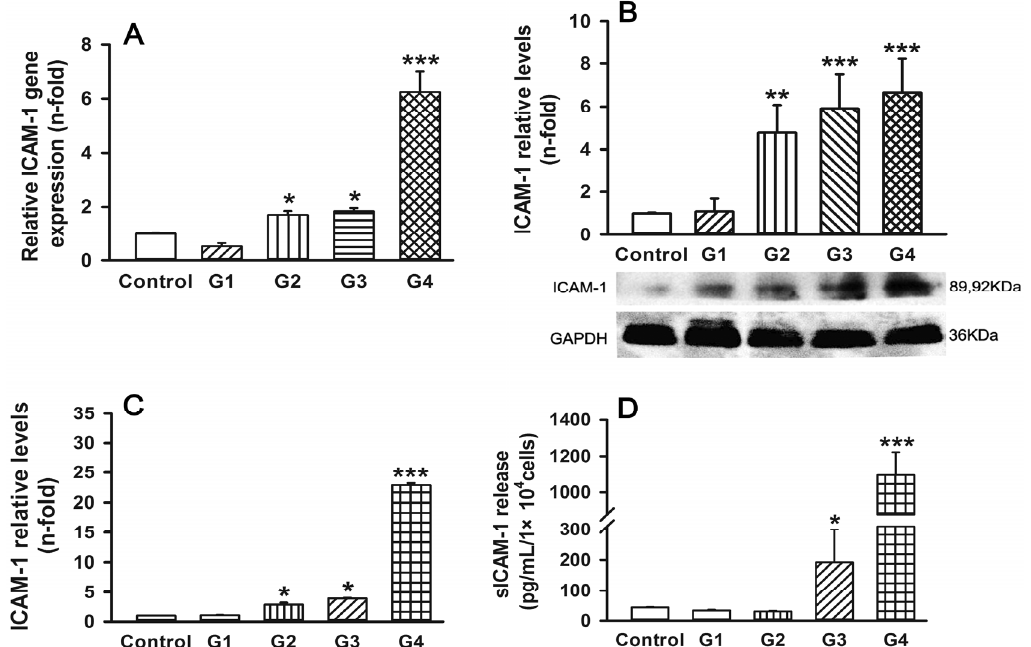
Figure 5. RSV-induced ICAM-1 expression and secretion in 16HBE cells. ( A ) Total RNA was analyzed for ICAM-1 mRNA levels; ( B ) Whole-cell lysates were analyzed for ICAM-1 protein levels using western blotting; ( C ) ICAM-1 protein levels were expressed in terms of absorbance at 450 nm using a whole-cell ELISA; and ( D ) Culture supernatants were analyzed for soluble ICAM-1 (sICAM-1) concentrations using ELISA. Symbols signify statistical significance, where * p < 0.05, ** p < 0.01, and *** p < 0.001 compared with control (non-inoculated